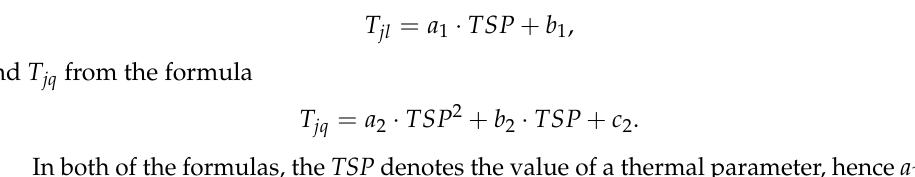
Figure 8. Dependences of the difference between the transistor M 1 die temperature that were calculated using the linear T jl and the quadratic T jq approximations of thermometric characteristics. The temperature T jl was computed from the